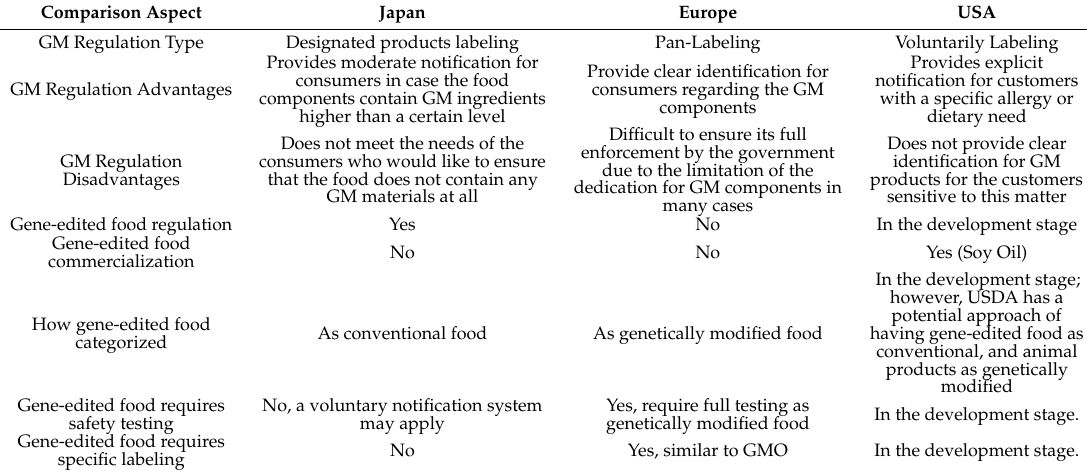
Table 1. Genetically modified food (GMO) and Gene Editing Regulations in Japan, Europe, and the USA (Reviewed: March 3,